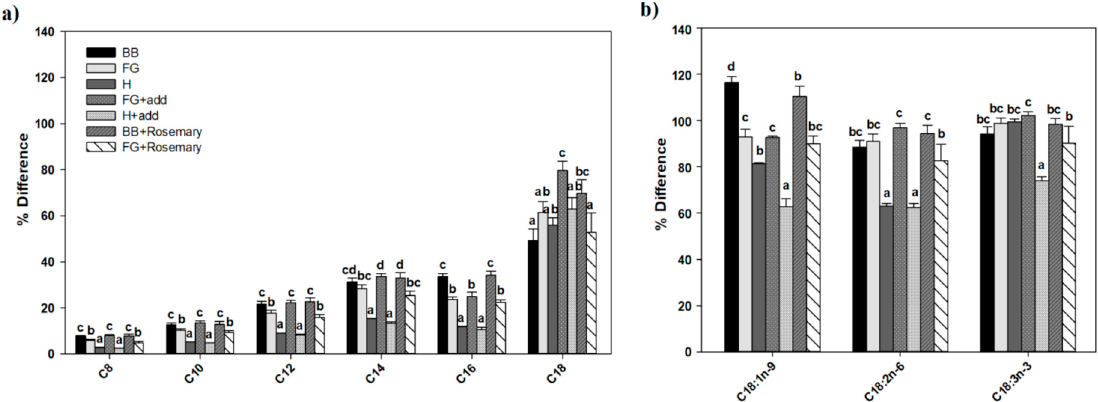
Figure 3. The effects of cold saponification and natural additives on the percent change in ( a ) saturated and ( b ) unsaturated unsaponified fatty acids in different commercial natural soaps. Values represent means ± standard errors. Means in the same row accompanied by different letters are significantly different between treatments at LSD = 0.05, n = 4 per experimental replicate.